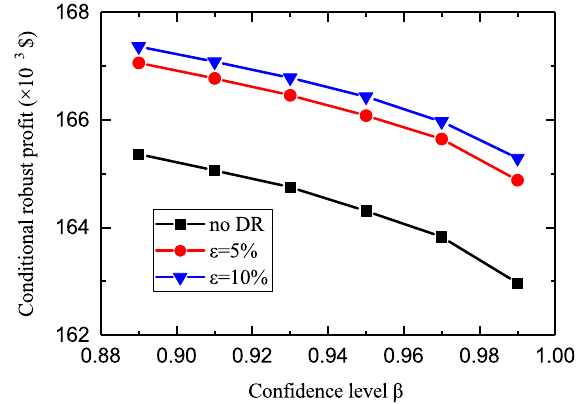
Figure 8. CRP for different load-shift capability.